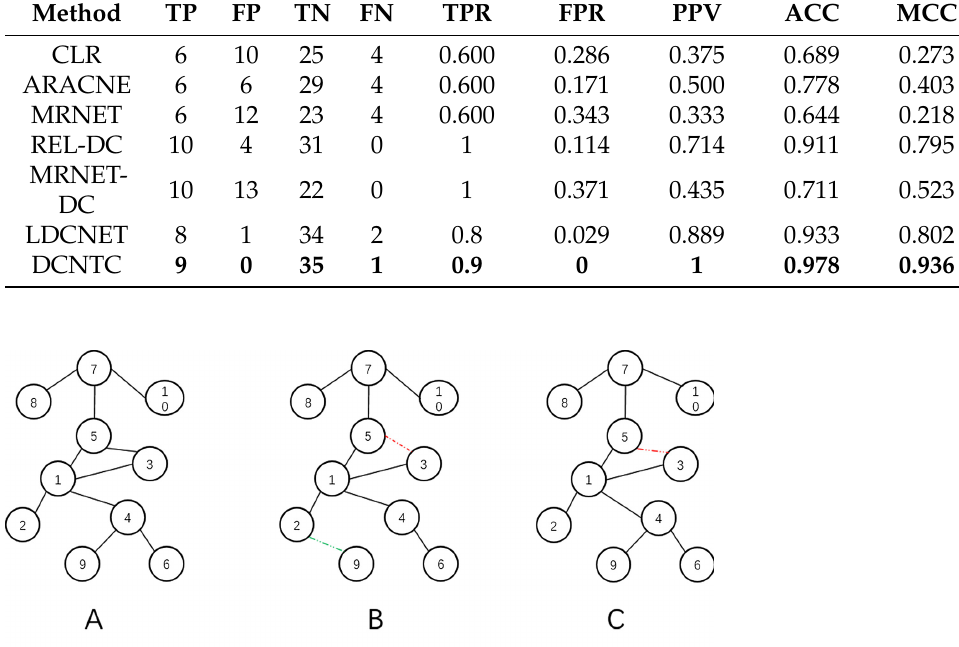
Figure 2. Comparison of a 10-gene network inferred from a DREAM3 dataset. ( A ) The true network with 10 nodes and 10 edges. ( B ) The network inferred by LDCNET from gene expression data. The edge with red dotted lines G3–G5 is false-positive, while the edge G2–G9 is false-negative. ( C ) The network inferred from gene expression data. The false-negative edge G2–G9 in LDCNET was successfully removed by